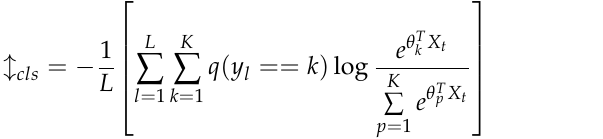
Table 1. The detailed parameters of the proposed RCAA-Net. Layers Output Size Convolution layer 256 × 256 × 16 Residual block1 128 × 128 × 32 Residual block2 64 × 64 × 64 Residual block3 Feedback self-calibration module 1 Feedback self-calibration module 2